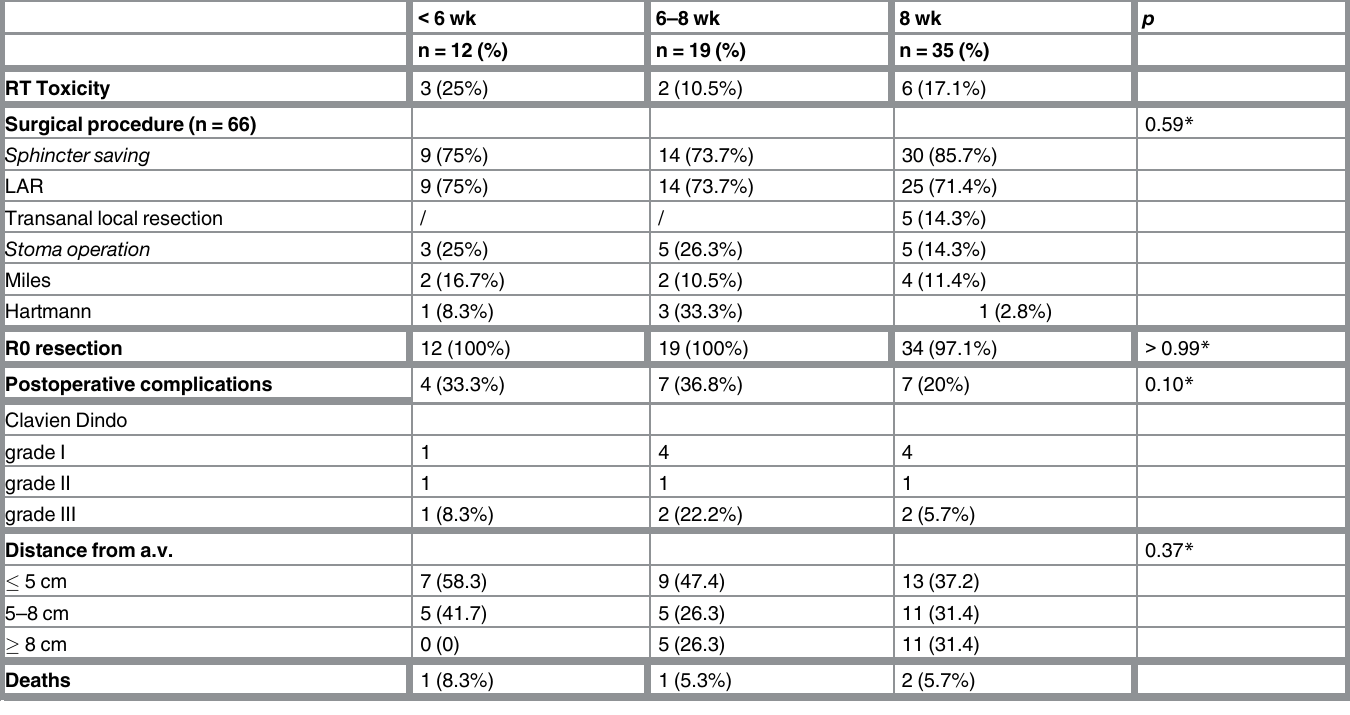
Table 2. Compliance of radiotherapy and surgical procedures according to different intervals.